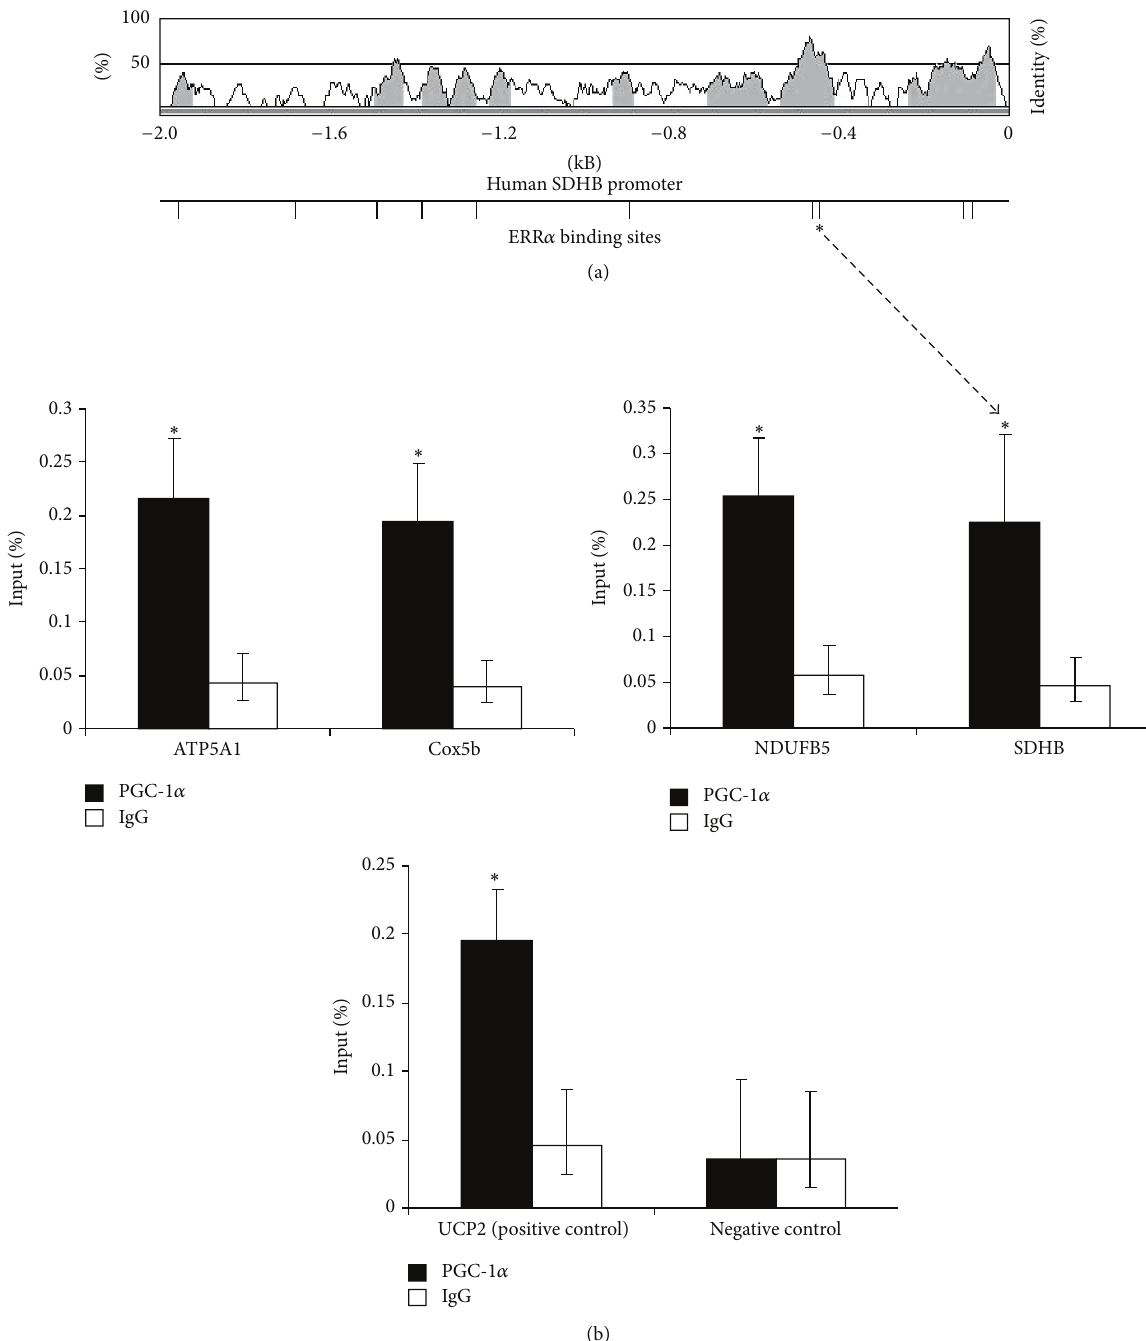
Figure 3: PGC-1 𝛼 physically associates with evolutionary conserved ERR 𝛼 binding motifs in the promoters of neuronal electron transport chain genes that are dysregulated in Parkinson’s disease. (a) The VISTA plot of a 2-kb promoter region of the SDHB gene is shown with percentage identity of the human and mouse sequences. Small vertical bars indicate the location of conserved predicted ERRE binding motifs and the asterisk indicates the binding motif assayed by quantitative chromatin immunoprecipitation. (b) Quantitative chromatin immunoprecipitation (qChIP) analyses in SK-N-MC neuroblastoma cells transfected with a myc-tagged PGC-1 𝛼 plasmid construct were performed. Promoter fragments for ATP5A1 (complex V), COX5B (complex IV), NDUFB5 (complex I), and SDHB (complex II) were specifically enriched in the IP fraction of PGC-1 𝛼 compared to IgG control indicating PGC-1 𝛼 occupancy of the conserved ERRE motifs. UCP-2 , a known transcriptional target of PGC-1 𝛼 [22], was used as positive control. No PGC-1 𝛼 occupancy was seen in intergenic regions lacking a predicted ERR 𝛼 binding site that was included as a negative control. Quantitative PCR data were normalized to genomic DNA and visualized as percent input. ∗ denotes 𝑃 value ≤